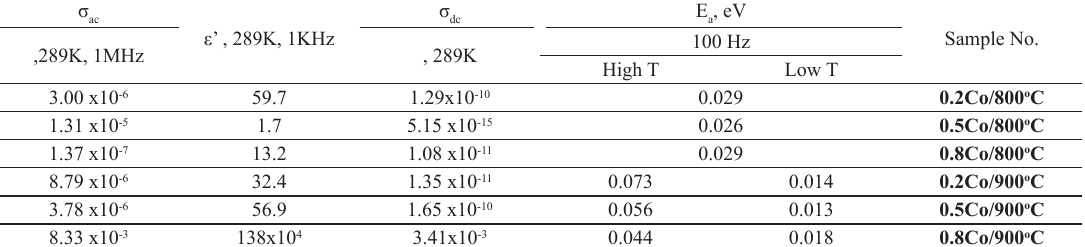
), dc conductivity, capacitance, dielectric constants of the samples prepared by solid state method at Table 3. The activation energies (E a room temperature and ac conductivity at 1 MHz and 1 kHz with an experimental error of ±2%.